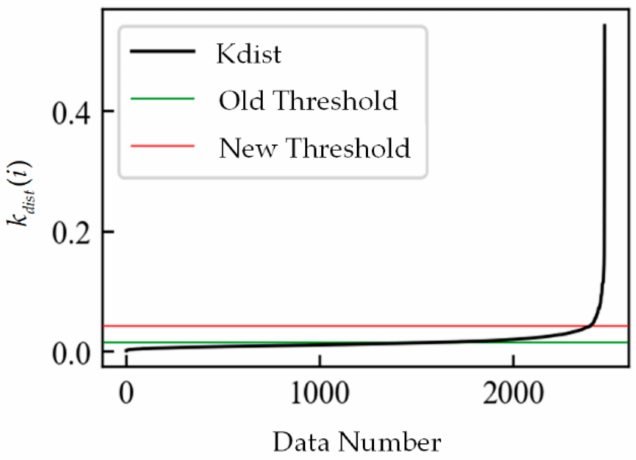
Figure 5. Outlier threshold.